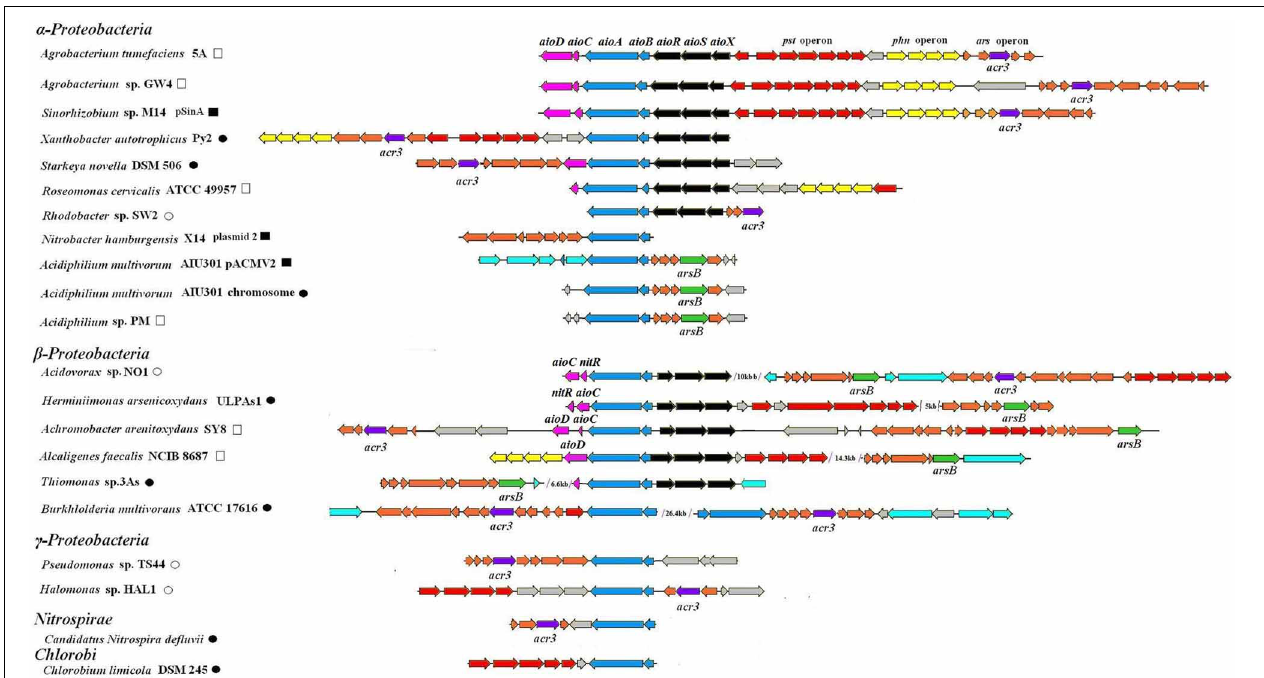
FIGURE 1 | Gene arrangements of the 21 arsenic islands. Arrows with different colors represent the following genes: blue for aioBA , black for aioXSR , pink for aioCD or nitR (encoding cytochrome c and molybdenum biosynthesis protein or nitroreductase, respectively), red for pst operon, yellow for phn operon, orange for ars operon in which green for arsB , purple for acr3 , light blue for mobile element. (cid:2) and (cid:2) represent the reported and predicted plasmid-originated sequences, respectively. • and ◦ represent the reported and predicted chromosome-originated sequences, respectively. GenBank accession numbers are as follows: Acidovorax sp. NO1 (AGTS01000000), Herminiimonas arsenicoxydans ULPAs1 (CU207211),